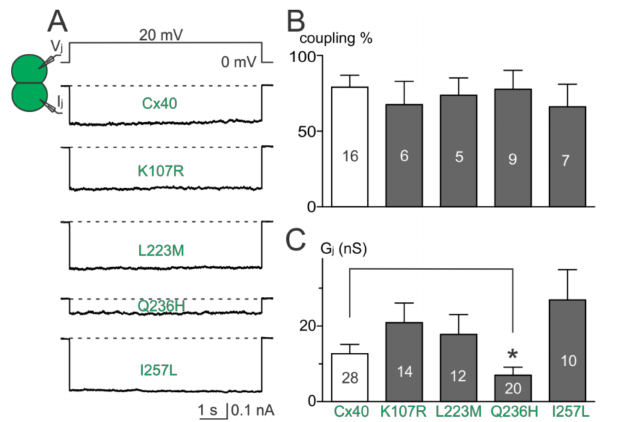
Figure 2. Coupling percentage and G j of AF-linked mutants. ( A ) Dual whole-cell patch clamp technique was used to measure junctional current (I j ) from N2A cell pairs expressing untagged Cx40, K107R, L223M, Q236H, or I257L at 20 mV V j ; ( B ) bar graph summarizes the coupling percentages of cell pairs expressing the AF-linked Cx40 mutants. No statistical difference was observed between each of the mutants and the wildtype Cx40. The number of transfections is indicated on each bar; ( C ) bar graph illustrates the coupling conductance (G j ) of coupled cell pairs expressing Cx40, K107R, L223M, Q236H, or I257L. Cell pairs expressing Q236H showed a significantly lower G j than those of wildtype Cx40 (* p < 0.05). The number of cell pairs is indicated on each